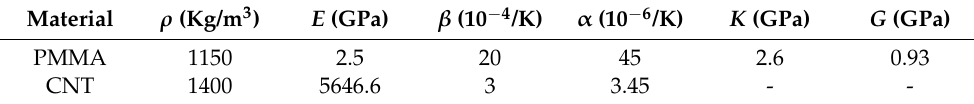
Table 4. CNTRC skin material properties [17].